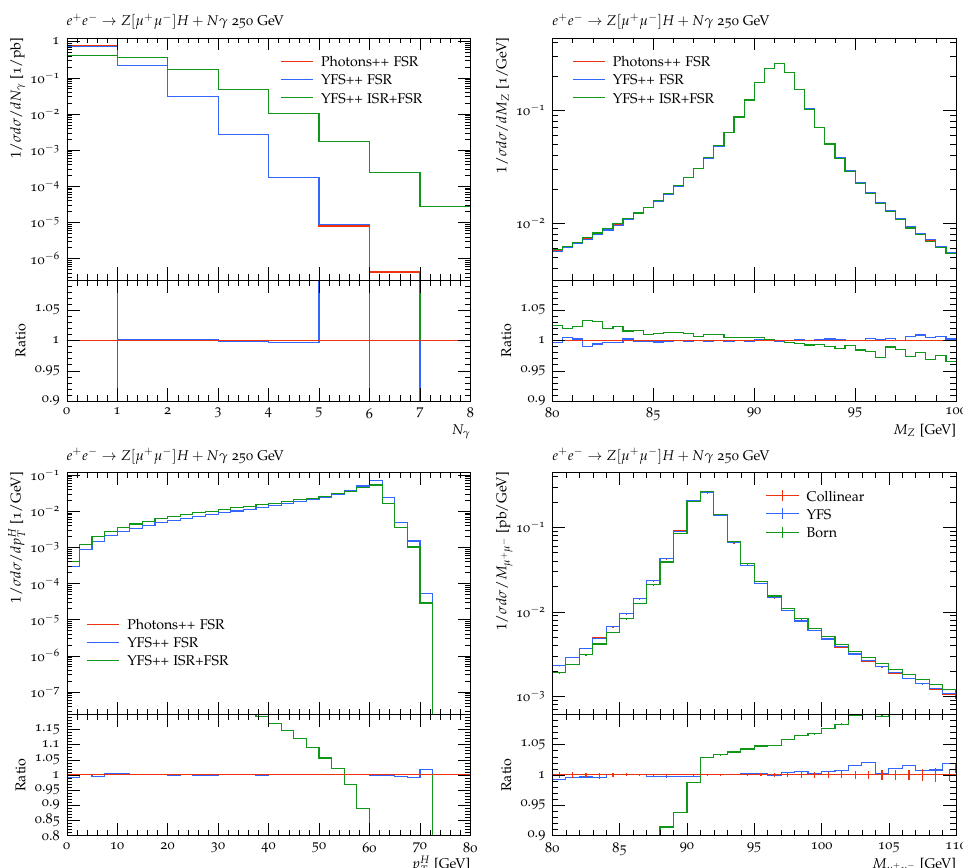
Figure 9: Photon multiplicity for P HOTONS module and the new implementation (top left), contrasting pure FSR (red and blue) as well the combined ISR + FSR (Green), the reconstructed Z resonance mass (top right), and the Higgs transverse momentum (bottom left). The reconstructed Z mass, again, contrasting the impact of ISR as modelled in collinear factorisation and YFS resummation (bottom right) as further